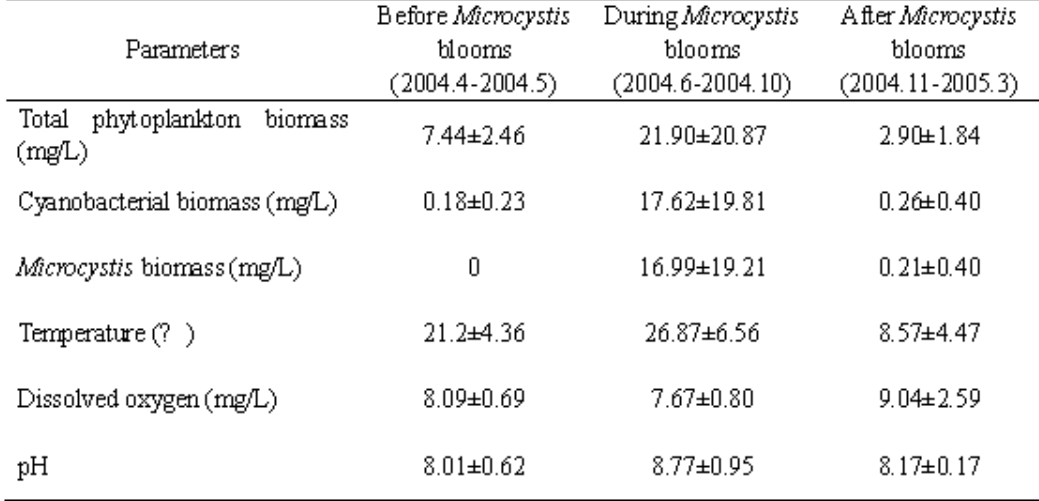
The Mean Values of Physical Parameters and the Phytoplankton Biomass in the Fish Pen Before, During, and After Microcystis